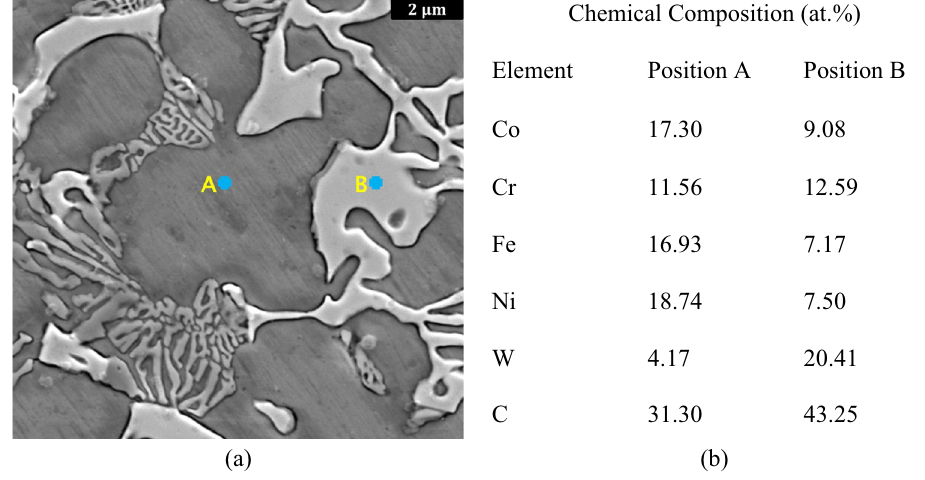
Figure 4. ( a ) SEM image and ( b ) EDS analysis of the CoCrFeNi-20 wt% WC